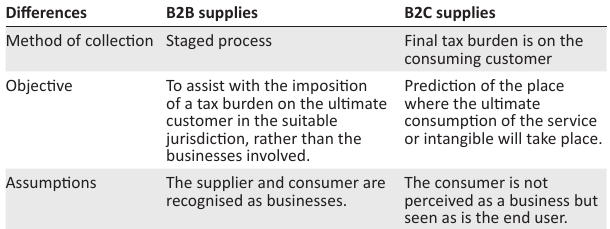
TABLE 3: Differences between business-to-business supplies and business-to- consumer supplies.